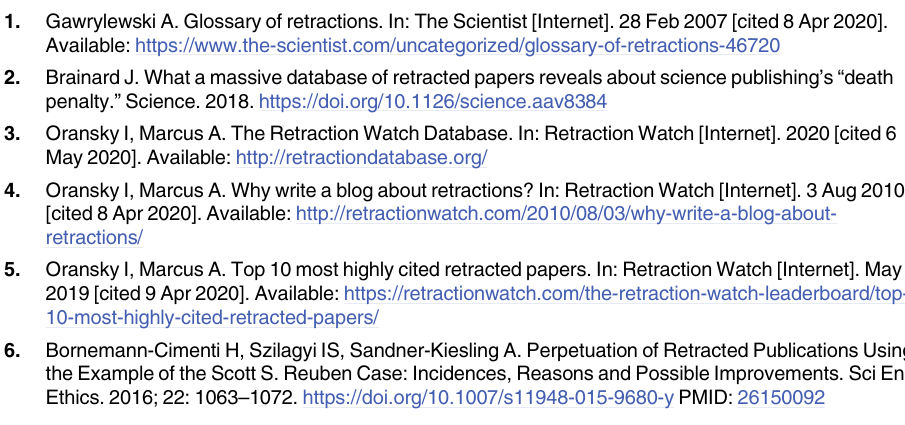
S5 Table. Pairwise comparison of original article vs. retraction notice when considering total post-retraction AAS. The “Total” columns compare the total AAS received by the origi- nal article against the total AAS received by their retraction notice. The “Pre-retraction” col- umns compare the AAS received by the original article before retraction versus the attention received by its retraction notice plus any post-retraction attention directed to the original arti- cle. The values in parentheses are the IQR for the median and the standard deviation for the mean. The p-value is from a Binomial test of articles with greater original vs. retraction atten- tion. Not all articles for “Total” qualified for